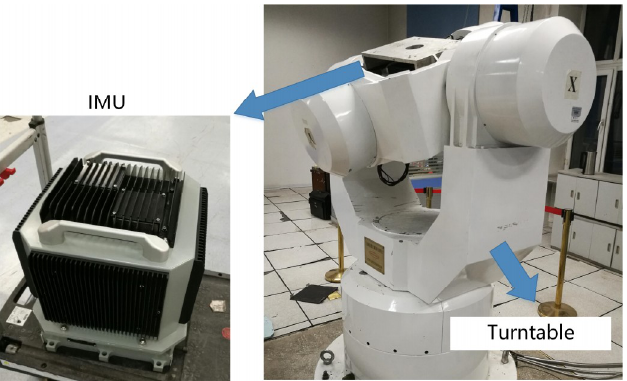
Figure 4. The high-precision three-axis turntable and the inertial measurement unit (IMU) in the temperature control box.